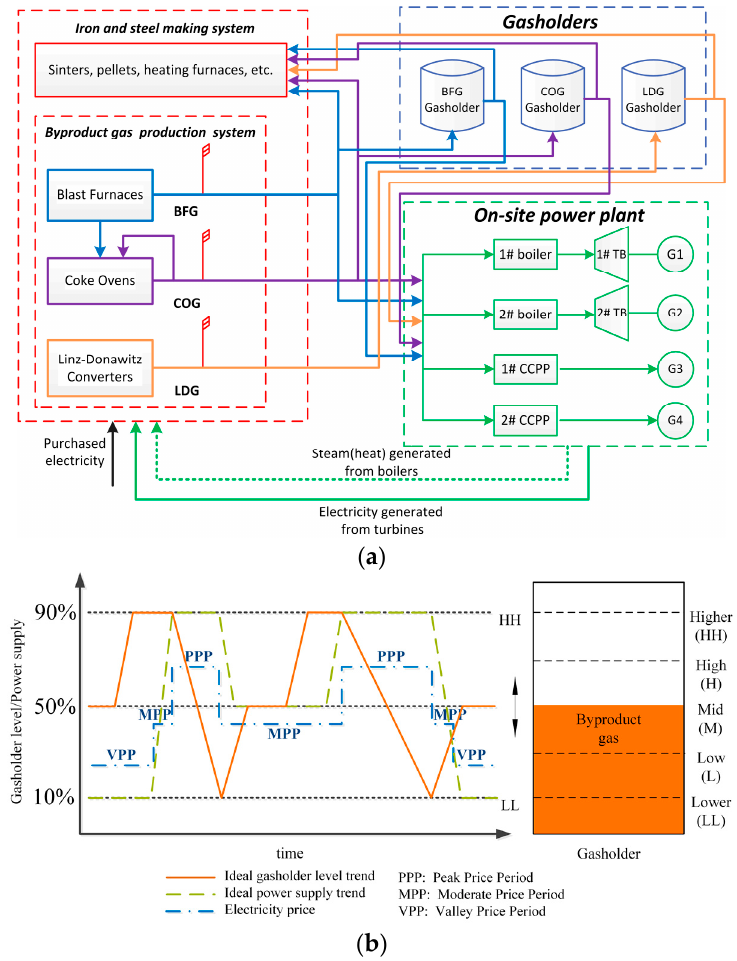
Figure 1. ( a ) Diagram of a byproduct gas system in a steel plant; ( b ) schematic view of the collaboration between the gasholder level and the electricity generation of the on-site power plant (OSPP) under the time-of-use (TOU) tariff.